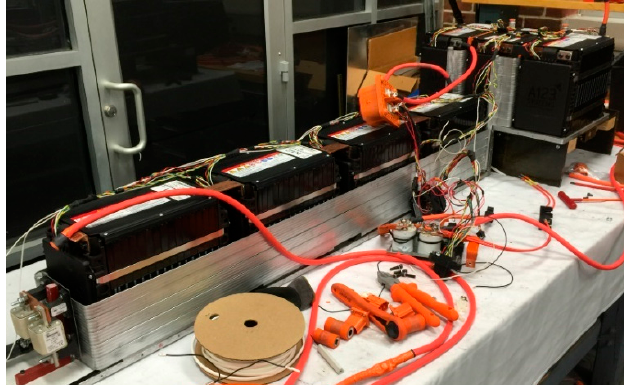
Figure 5. Picture of the real battery pack assembly.